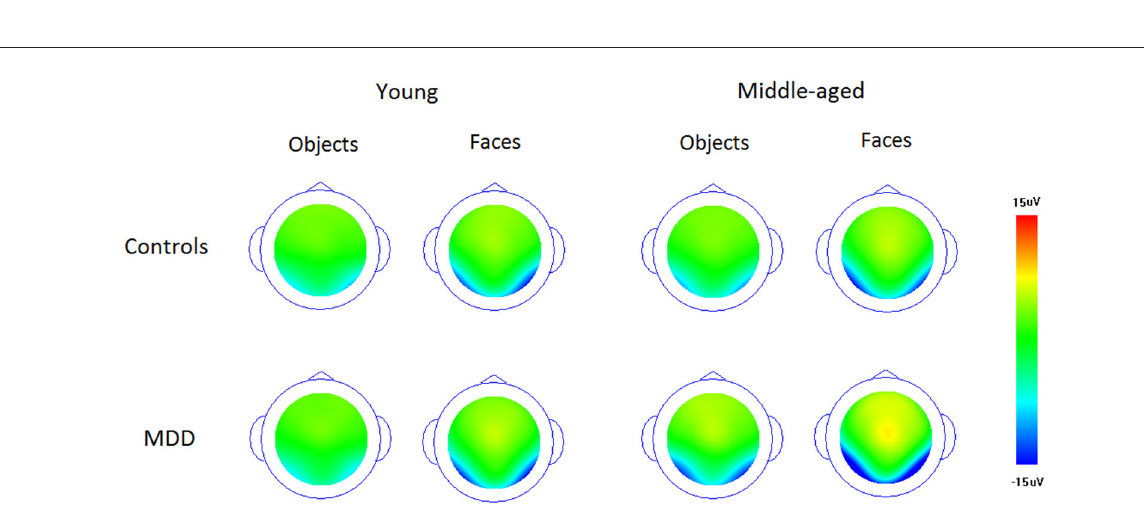
Importantly, several interactions were qualified by two group factors. Both the Orientation ∗ Depression [ F (1,111) = 4.1, p < 0.05, partial η 2 = 0.04] and Orientation ∗ Age interactions [ F (1,111) = 4.6, p < 0.05, partial η 2 = 0.04] were